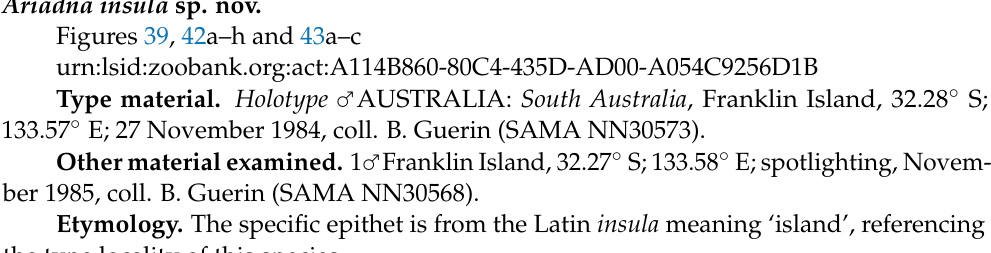
Figure 41. Ariadna inflata sp. nov. ♂ holotype (SAMA NN22460) from Yorke Peninsula (SA): ( a ) left pedipalp, prolateral view; ( b ) same, retrolateral view; ( c ) same, cymbium. Scale bar = 1 mm. Ariadna insula sp. nov.